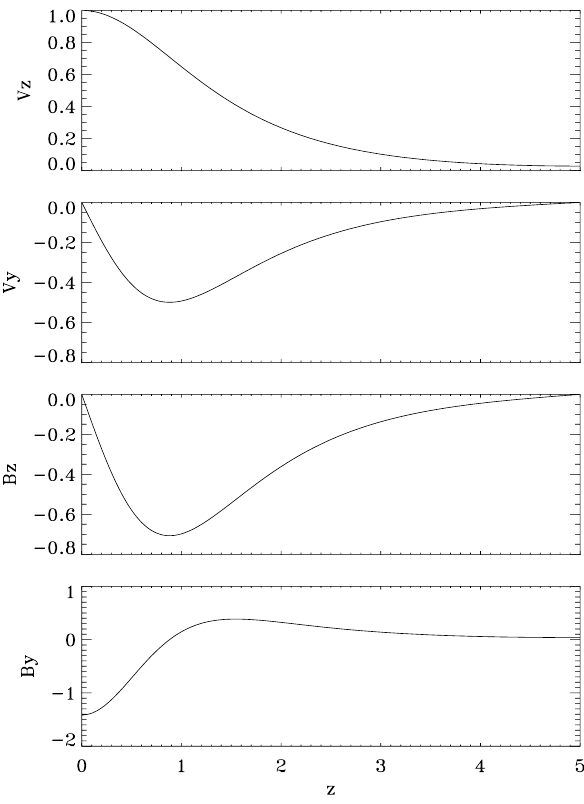
Fig. 4. Eigenfunctions corresponding to the “kink”